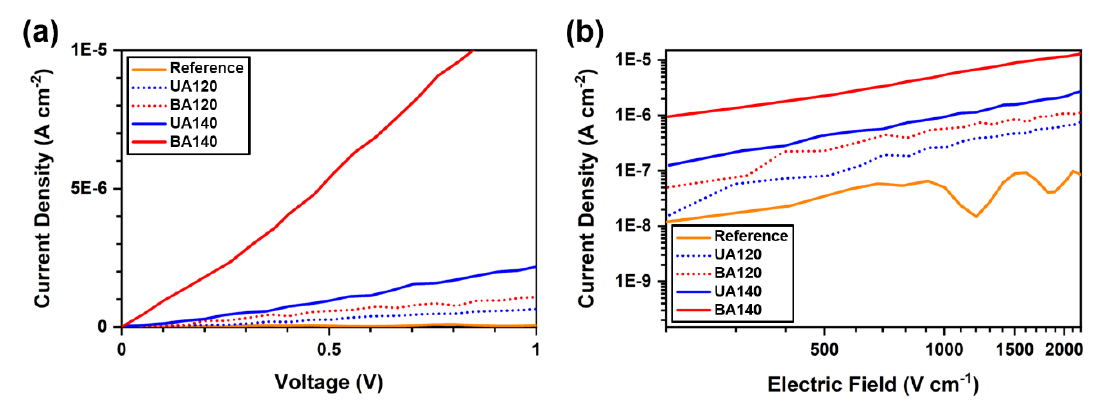
Figure 5. ( a ) Current density-voltage (J-V) characteristics of the devices using the reference, UA120, UA140, BA120, and BA140 electrodes, in a linear scale. The characteristics were measured in low bias region (i.e., ohmic current region). All the characteristics showed a linear relationship, and that the slope ratio of the device with the BA140 electrode to the reference devices was ~170. ( b ) Electric field dependence of the current density. All the slopes were measured to be ~1, indicating ohmic current in each device.